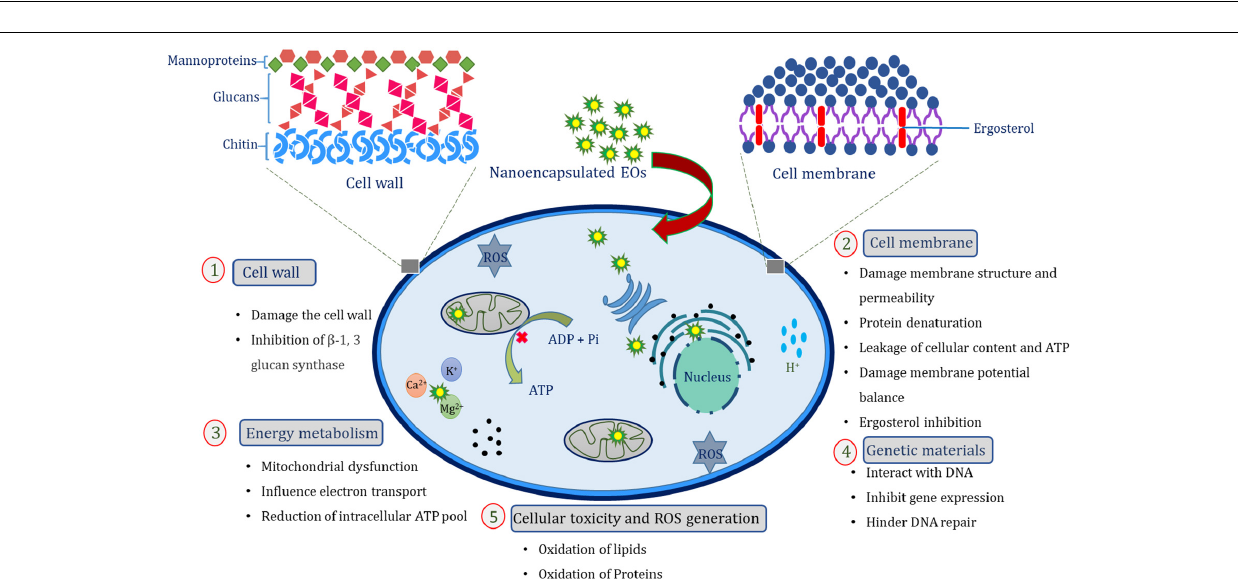
FIGURE 1 | Schematic representation of possible antibacterial mechanisms of action of EO nanoemulsion.